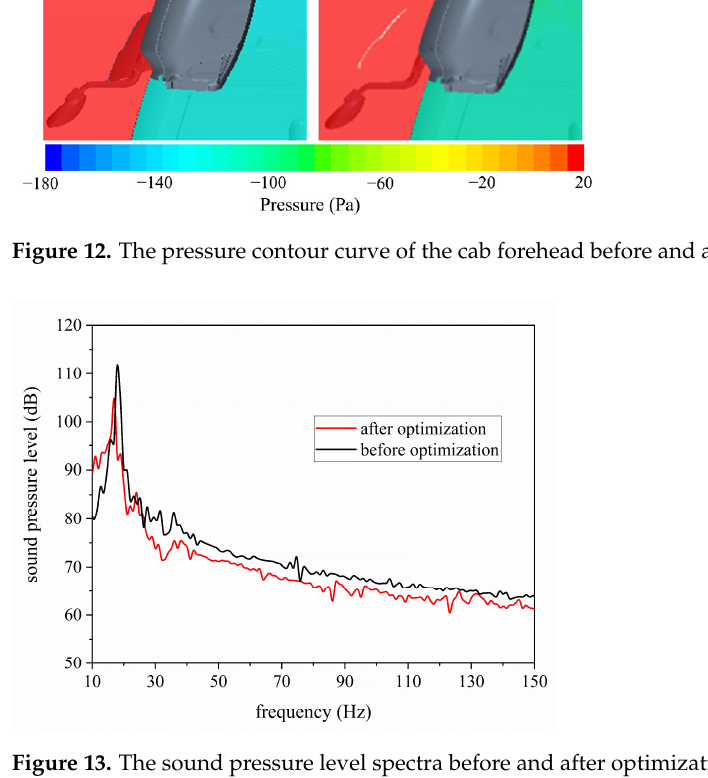
Figure 13. The sound pressure level spectra before and after optimization.